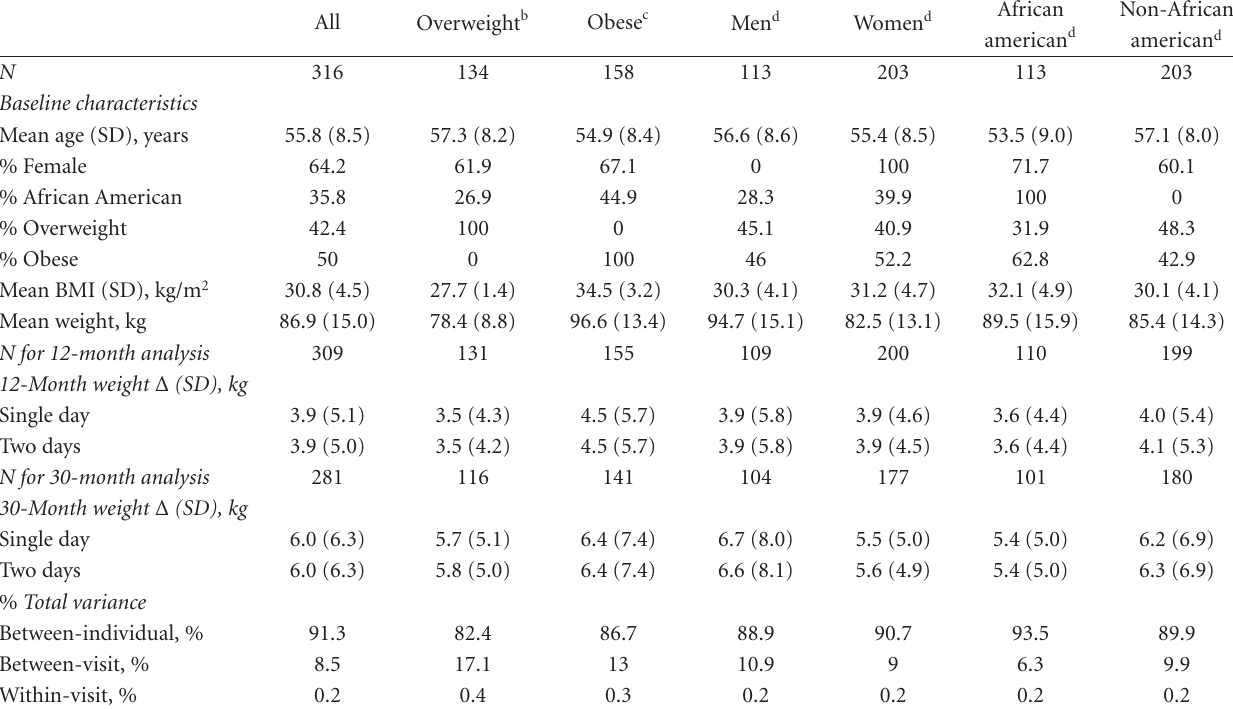
Table 1: Mean weight change (standard deviation) and weight variability among control participants in weight loss maintenance a .